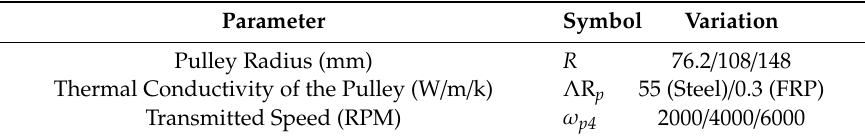
Table 1. Operating parameters.